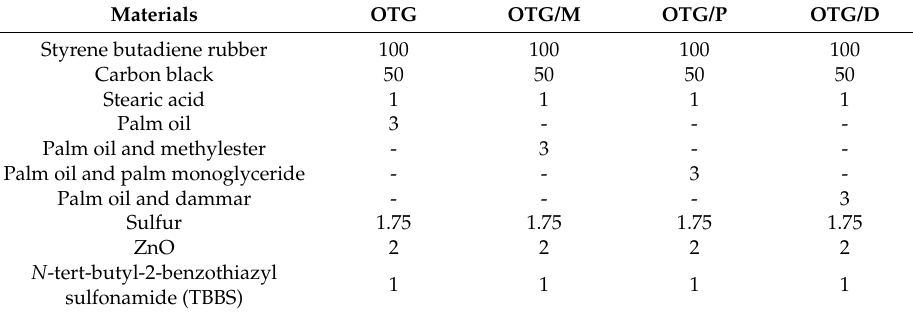
Table 1. Formulation of the elastomer